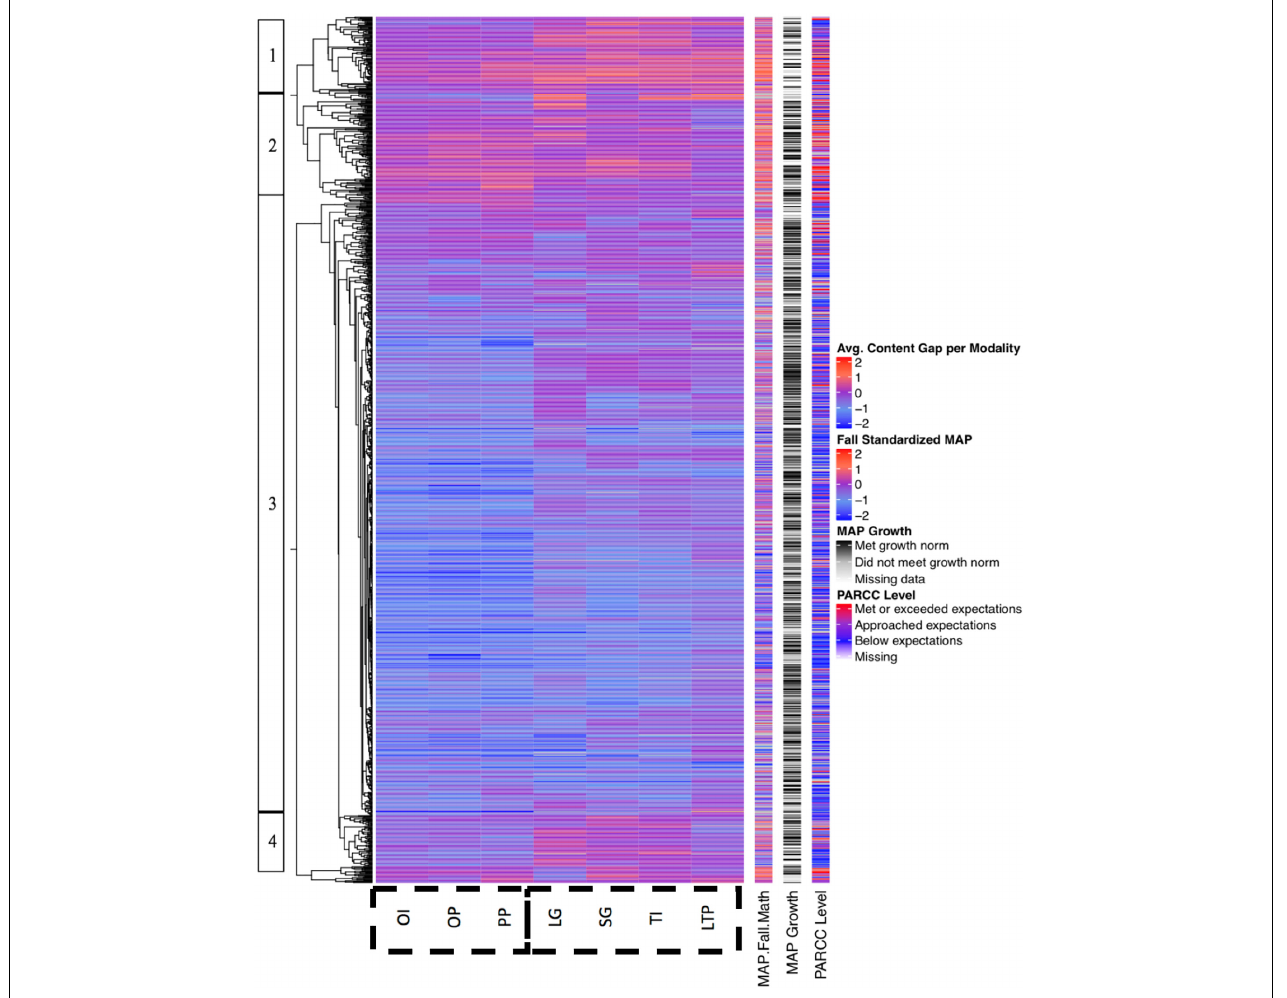
FIGURE 3 | Content gap disaggregated by instructional